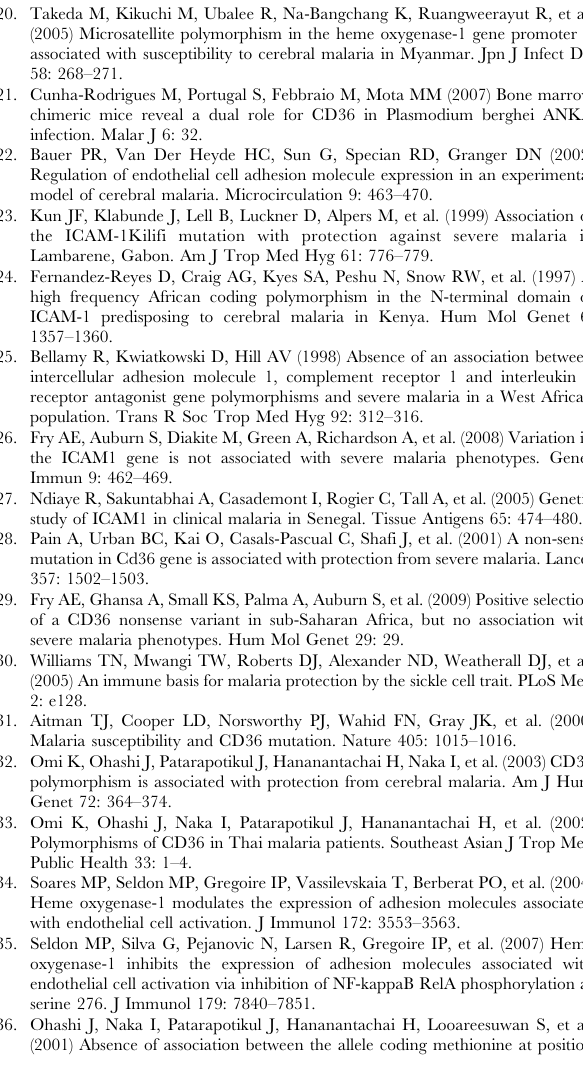
Table S3 Cerebral malaria association tests for single-nucleotide polymorphisms (SNPs) in the HMOX1, CD36 and ICAM1 genes. Found at: doi:10.1371/journal.pone.0011141.s003 (0.07 MB